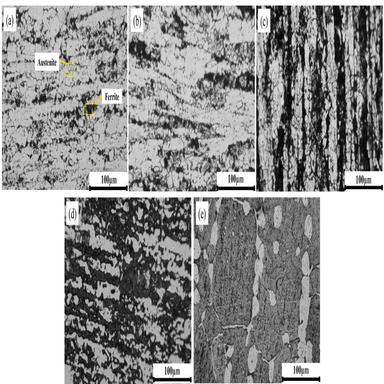
Metallography of industrial 2205 DSS with different phase fraction (a) after solid solution at 1050 ◦C for 30 min, hold at 850 ◦C for 120 min, (b) after solid solution at 1050 ◦C for 30 min, hold at 850 ◦C for 90 min, (c) hold at 1050 ◦C for 30 min, (d) hold at 1100 ◦C for 30 min, (e) hold at 1250 ◦C for 30 min.